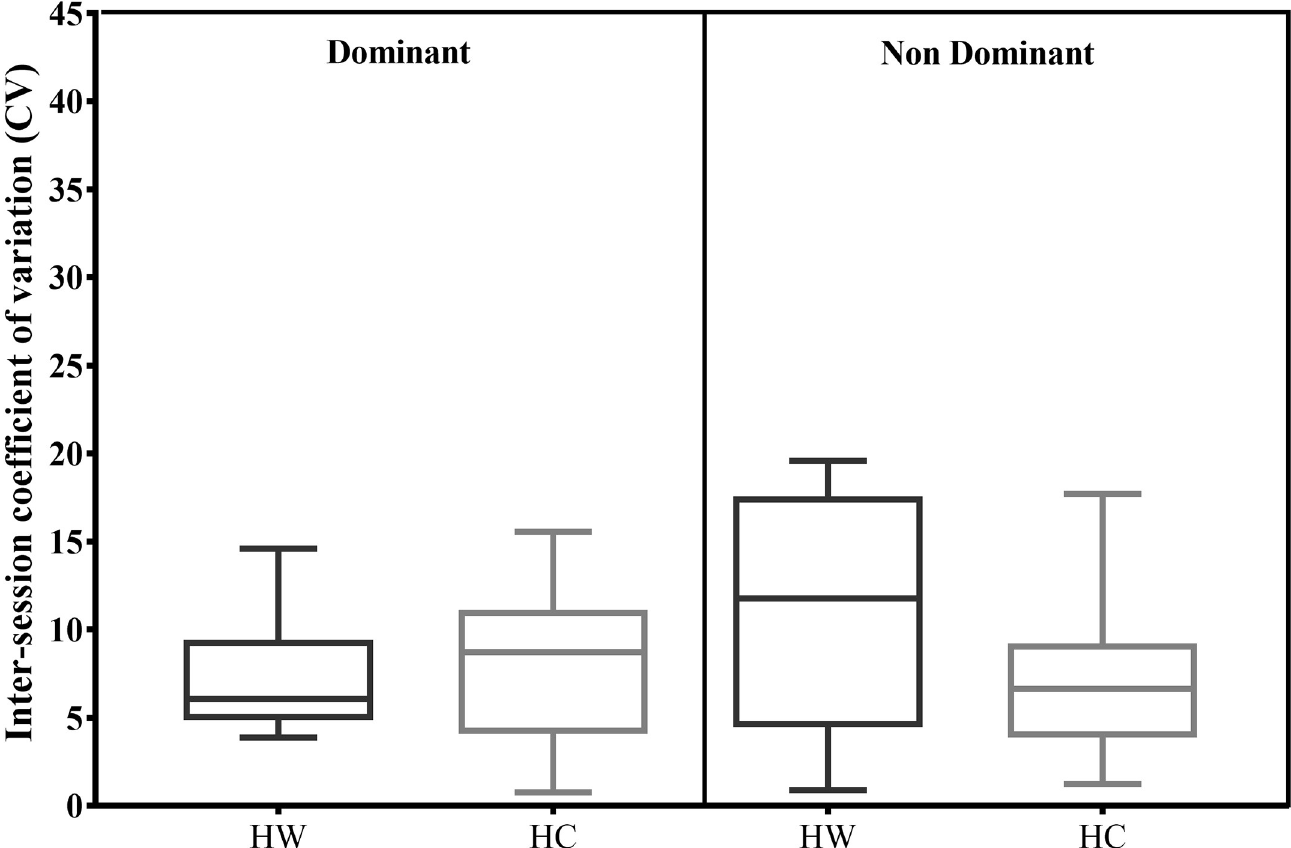
Fig 4. Inter-session median CV distributions with boxplots for D v ND limb in 90:20 hands-on-chest vs. hands-on-wall.